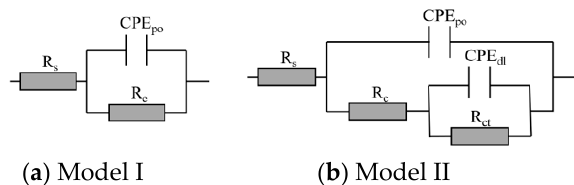
Figure 6. Equivalent electrical circuit models used for the EIS (electrochemical impedance spectroscopy) data ( a )-( b ).